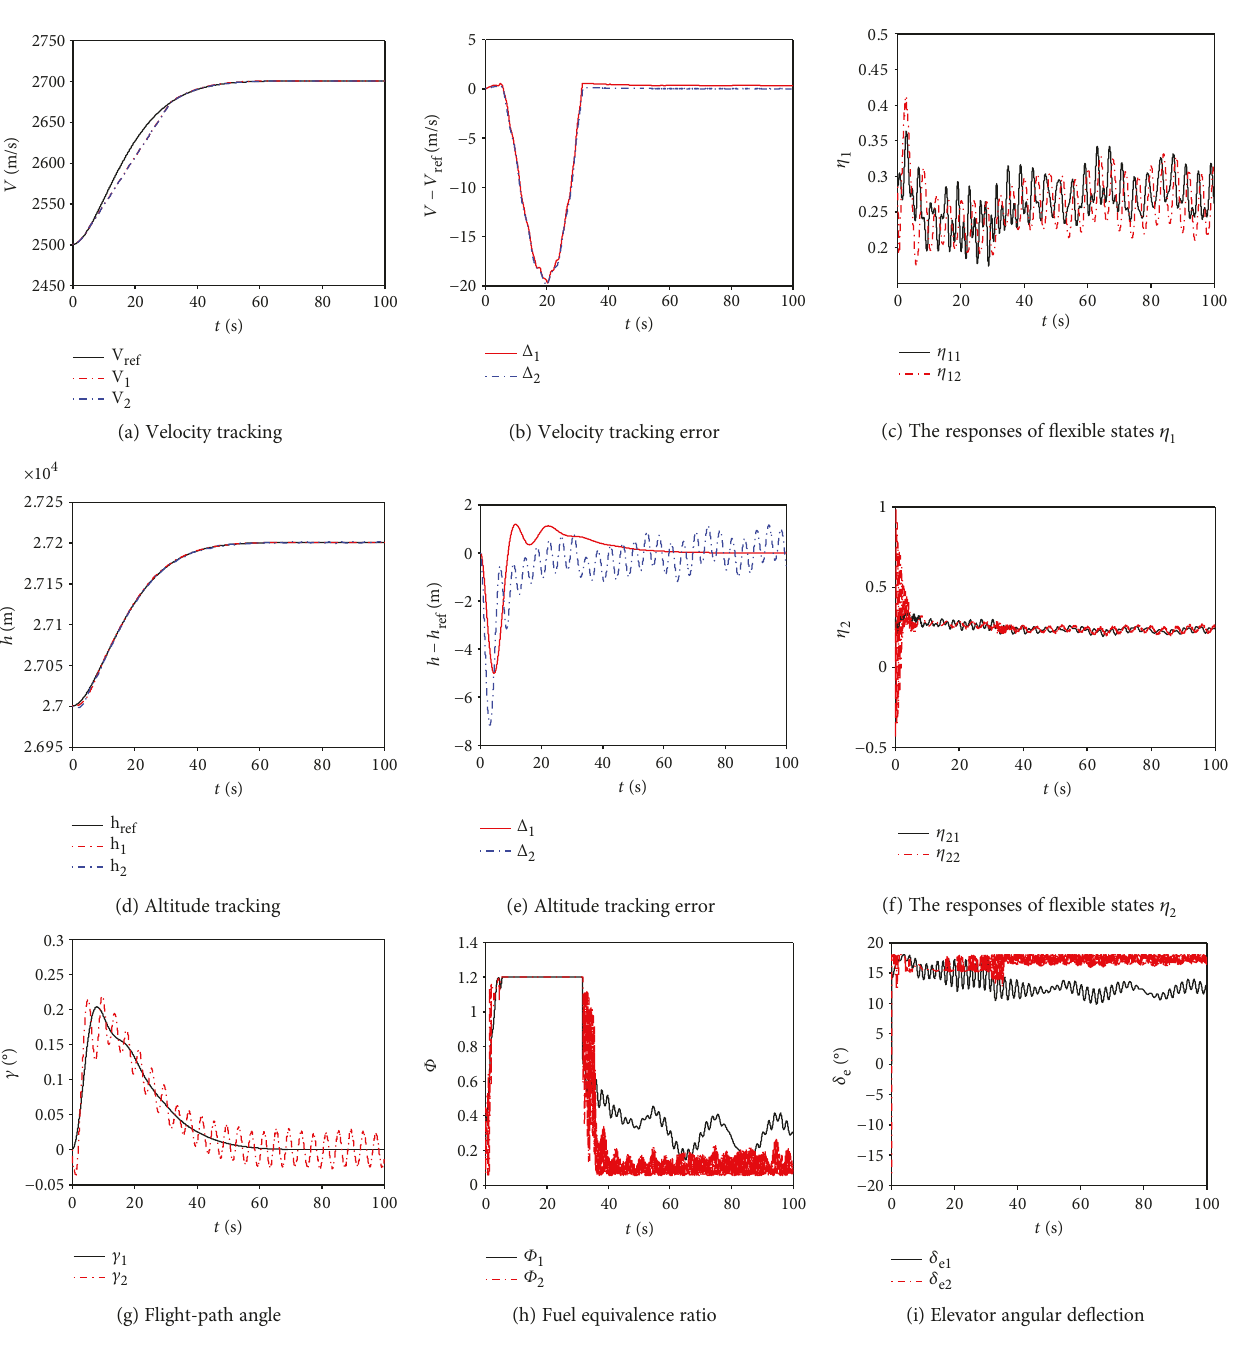
Figure 4: Simulation result of Case